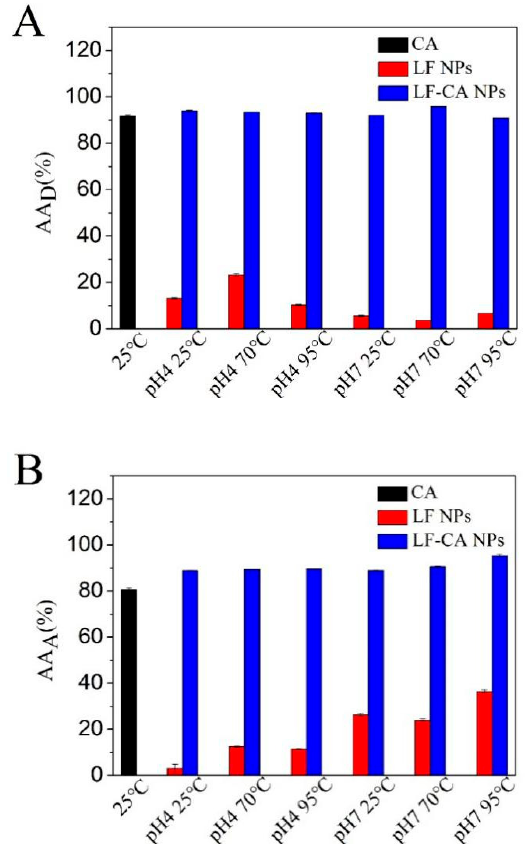
Figure 9. DPPH radical scavenging activity, and Hydroxyl radical scavenging activity of CA, LF NPs, and LF-CA NPs ( A : DPPH radical scavenging activity; B : Hydroxyl radical scavenging activity).